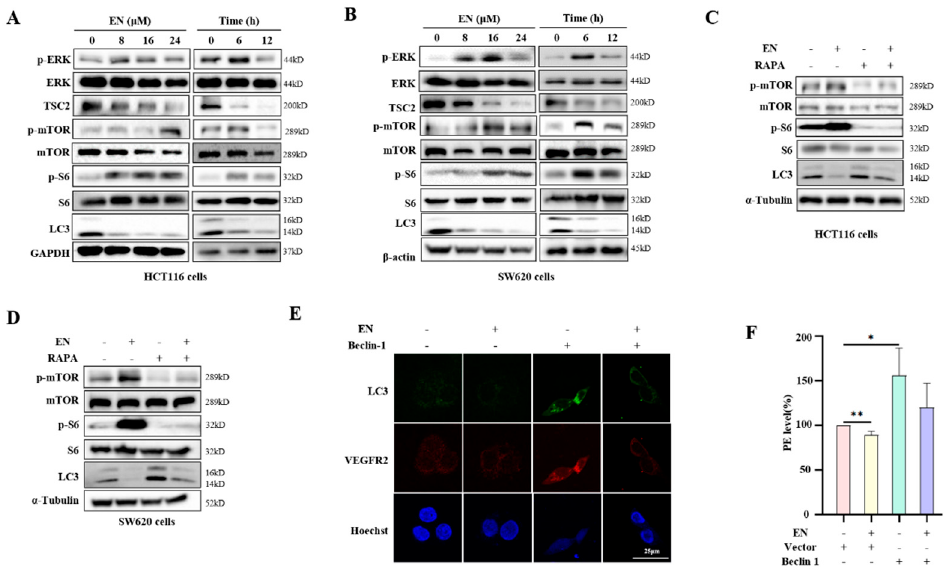
Figure 4. EN activates the mTOR signaling pathway and inhibits autophagy. ( A ) HCT116 cells were treated with different concentrations of EN (0, 8, 16, and 24 μ M) or with EN (16 μ M) for different times (0, 6, 12, and 24 h). Western blotting was used to analyze the phosphorylation levels of ERK, mTOR, and S6. ( B ) As in ( A ), SW620 cells were treated with EN and harvested for Western blotting analysis. ( C ) HCT116 cells were pretreated with rapamycin (200 nM) for 2 h and then continued to be treated with EN (16 μ M) for 24 h. Cells were harvested and lysed for Western blotting to detect the expression levels of mTOR, S6, and LC3. ( D ) As in ( C ), SW620 cells were pretreated with rapamycin and then continued to be treated with EN. Cells were harvested for Western blotting analysis. ( E ) HCT116 cells were first transfected with Flag-Beclin-1 for 24 h and then treated with EN (16 μ M) for 24 h. After fixation and permeabilization, cells were incubated with VEGFR2 conjugated to PE, and a confocal microscope was used to detect cell fluorescence. Scale bar: 25 μ m. ( F ) As in ( D ), cell fluorescence intensity was quantified by flow cytometry and was statistically analyzed. * p < 0.05, ** p < 0.01.